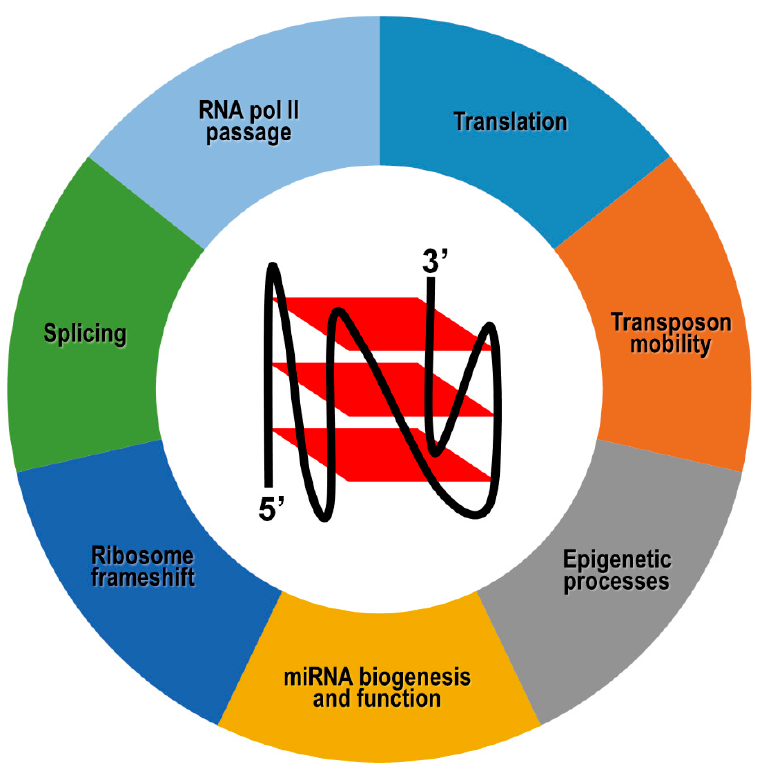
Figure 4. Molecular processes modulated by G4 structures formed in coding and noncoding RNA transcripts. A schematic drawing indicating the parallel topology adopted by RNA G4s is shown.